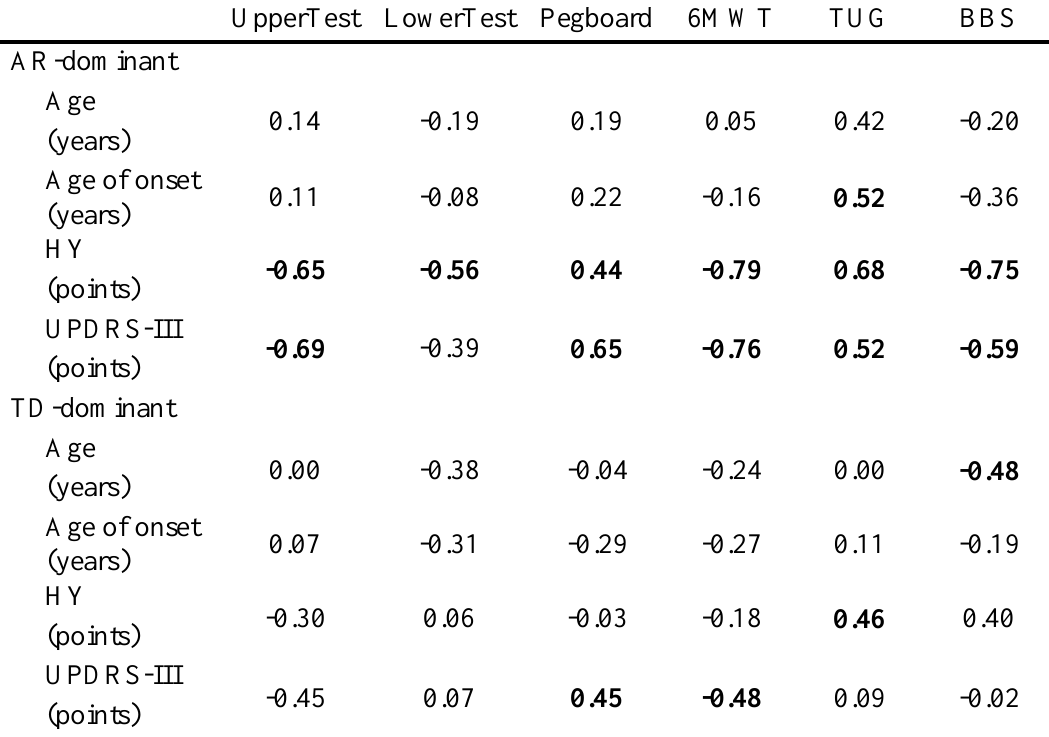
Table 2. Correlation coefficients between clinical outcomes and performance of functional capacity